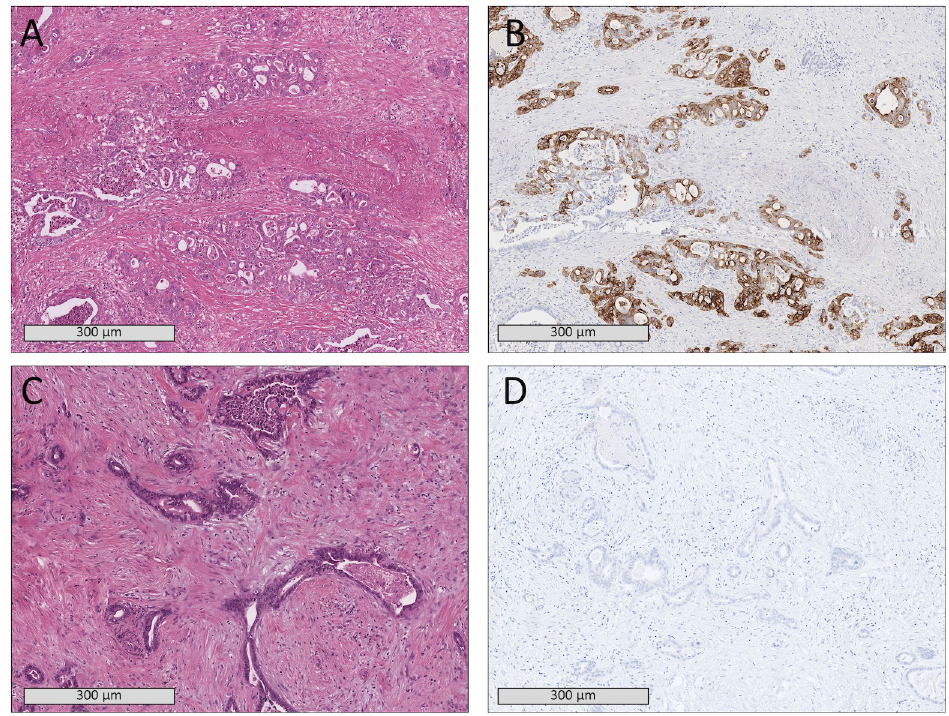
Fig 1. Histopathological samples of two patients showing comparable tissue morphology in H&E staining (A,C) but a KRT81+ subtype (B) in one patient and KRT81- subtype (D) in the other patient.